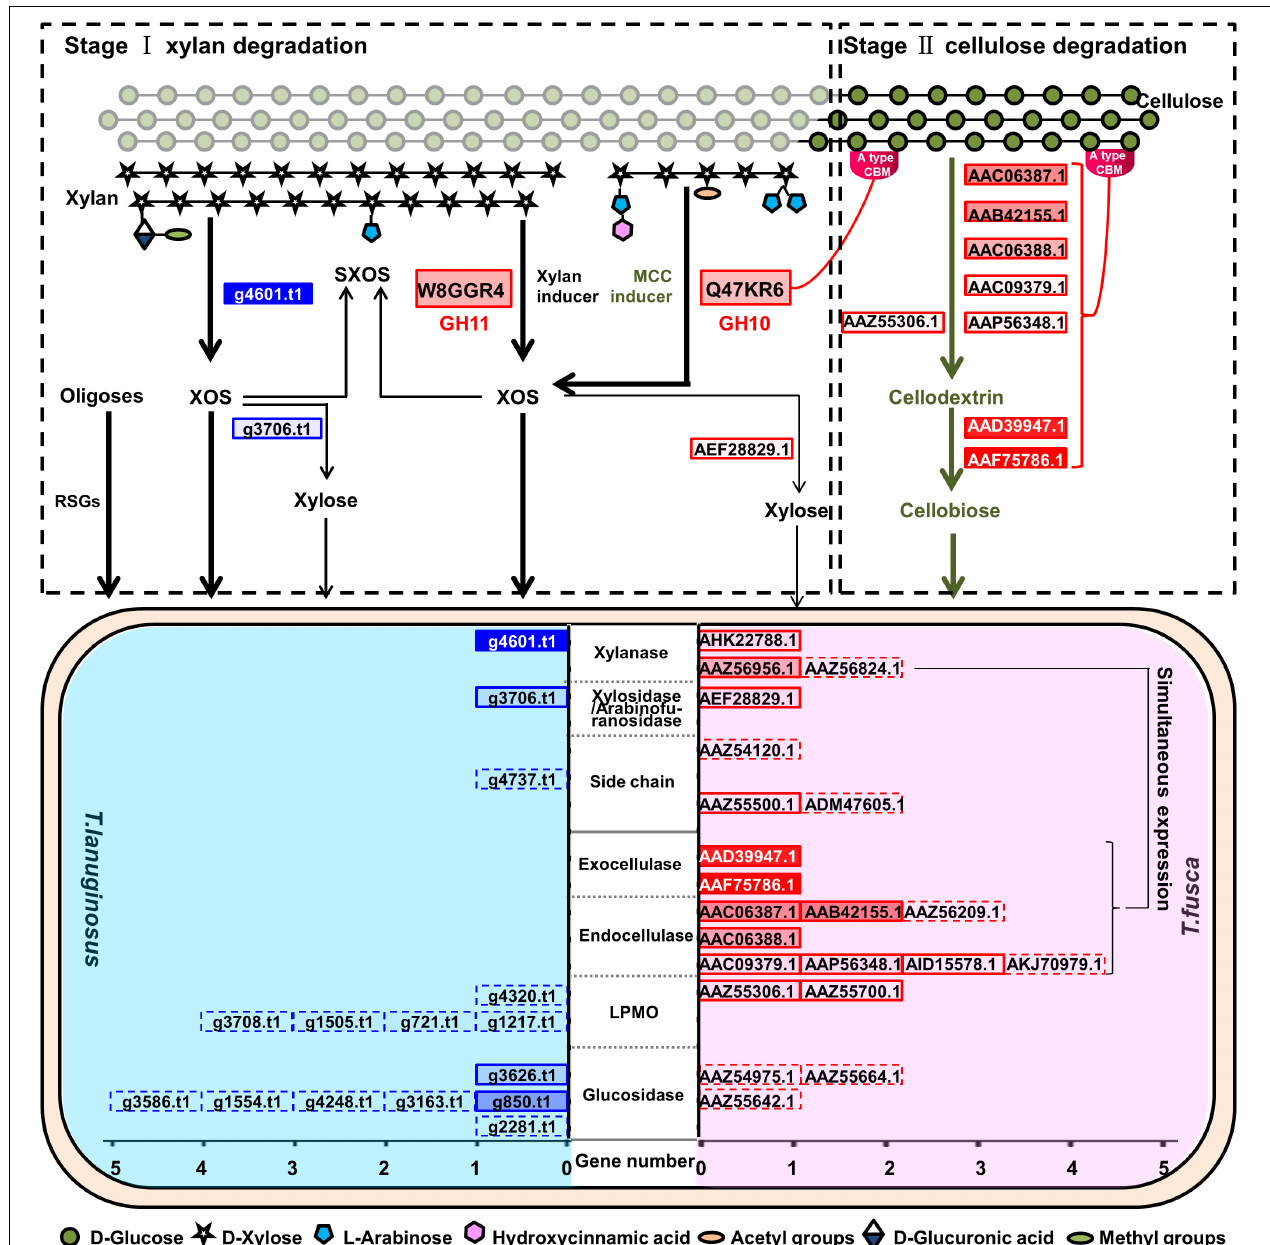
FIGURE 8 | Schematic diagram representing the synergistic lignocellulosic degradation mode of T. lanuginosus and T. fusca when they were grown in a same system. Solid boxes indicate the genes of the enzymes which were detected in the secretomes of T. lanuginosus and T. fusca . Dotted boxes indicate the genes of the enzymes which were not detected in the secretomes of T. lanuginosus and T. fusca . The brighter filling color of the box indicates the more expression of the proteins, and vice versa. Thick lines indicate the preferential reactions that are able to